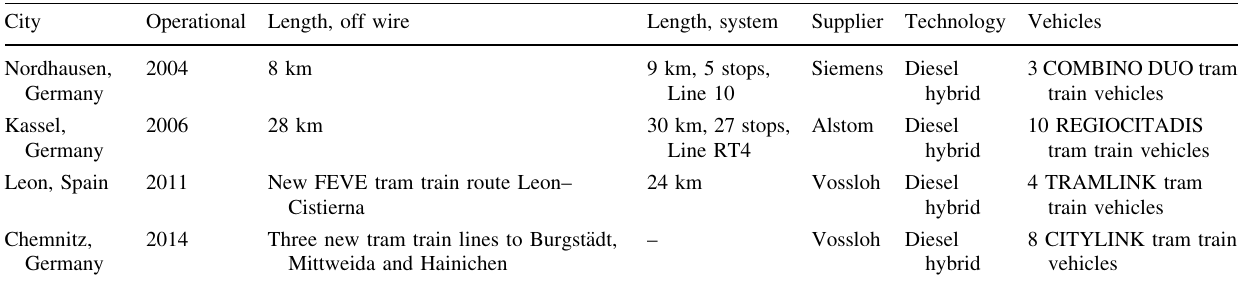
Table 4 Diesel hybrid (tram train) vehicles for off-wire operation ‘‘OPGS’’. ( Source : [9])